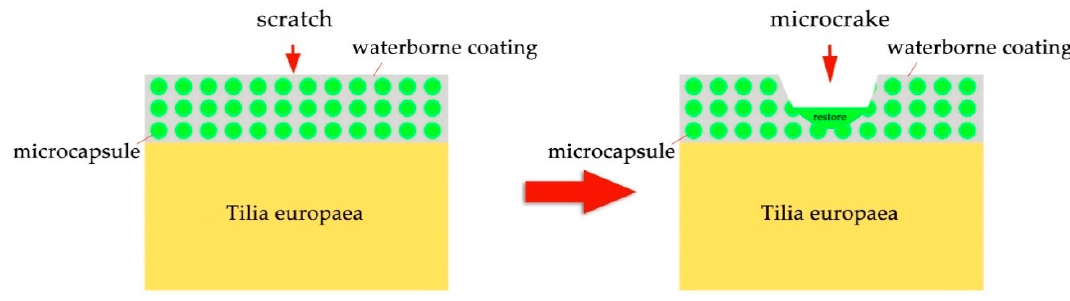
Figure 12. The self-repairing mechanism of waterborne coating microcapsules.